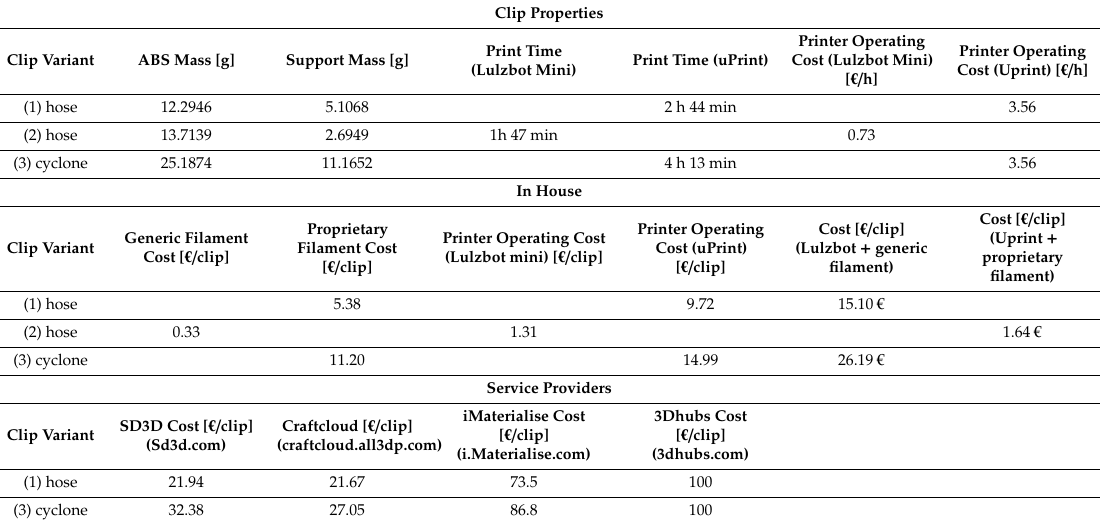
Table 1. Cost of di ff erent variants of the clip system according to experimental average mass. Clip